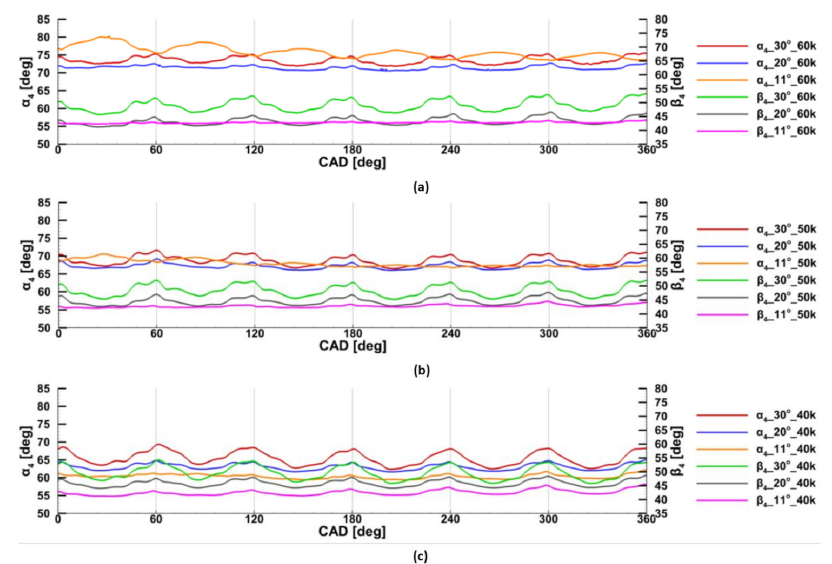
Figure 35. The absolute and relative angle at the outlet from the 2nd stage rotor for: ( a ) 60,000 rpm, ( b ) 50,000 rpm, ( c ) 40,000 rpm turbine speed. The absolute angle greatly depended on the turbine speed. Thus, with the increase of the turbine speed, the absolute angle increased, as shown in Figure 36a.